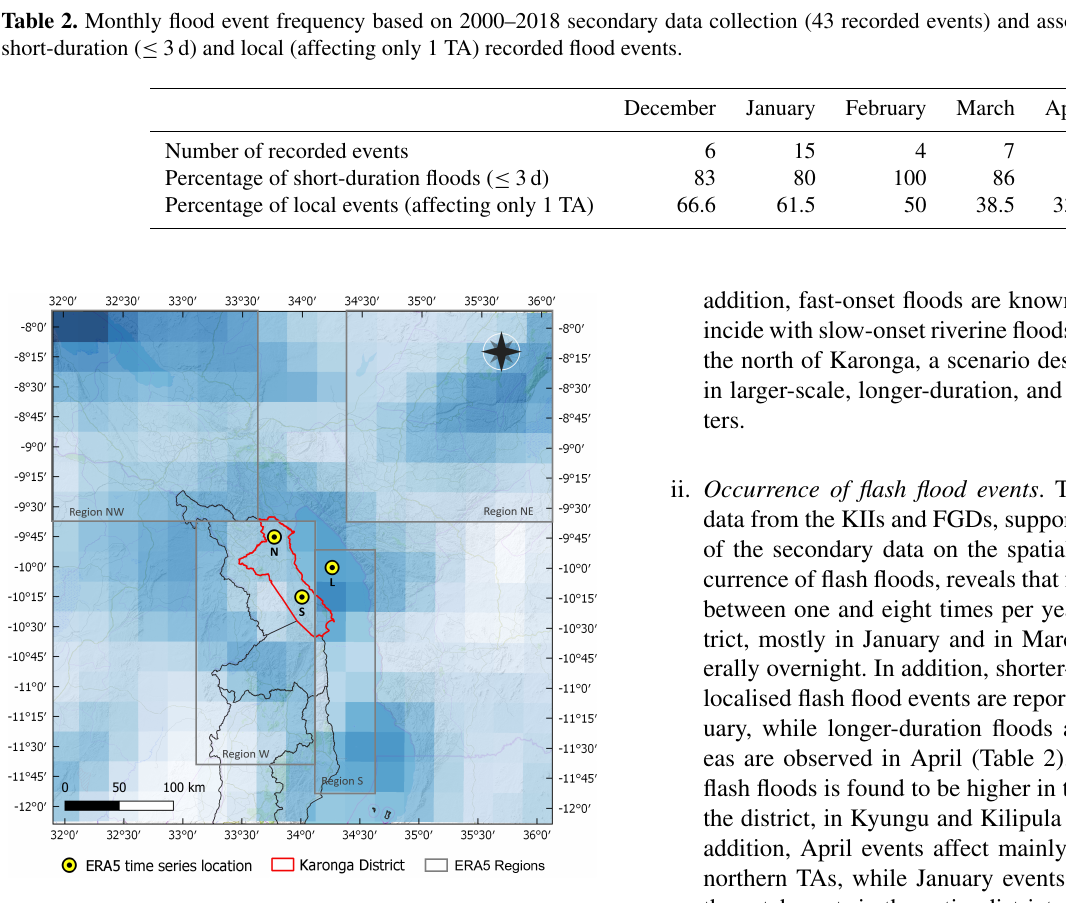
Figure 2. ERA5 grid resolution; x , y point locations (yellow dots); and four regions (NW: north-west, NE: north-east, W: west, and S: south) used for large-scale hydro-meteorological pattern analy-